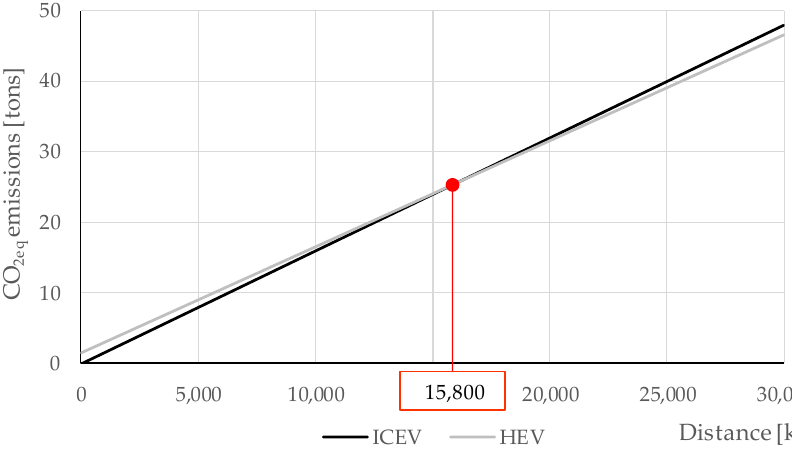
Figure 6. Break-even analysis (ICEV vs. HEV).